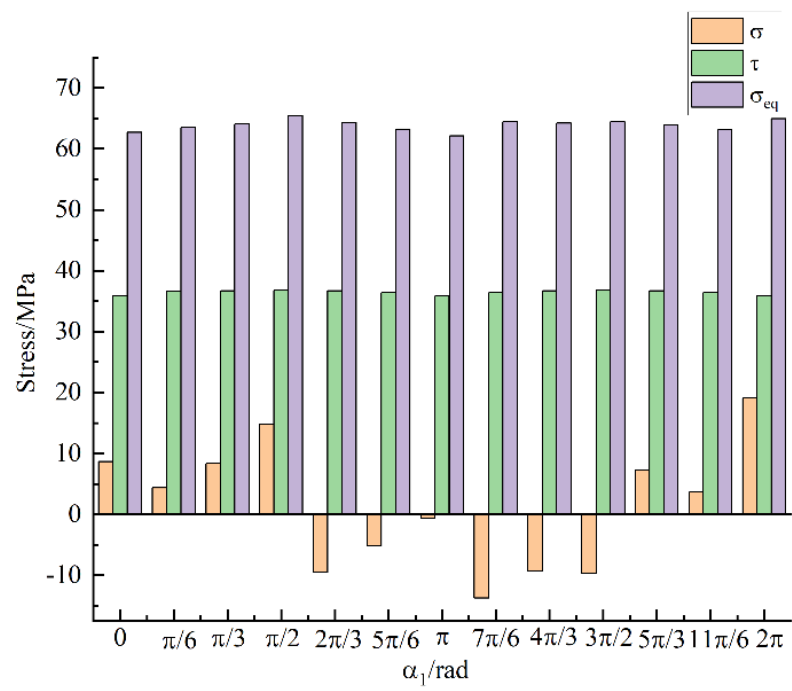
Figure 13. Diagram of stress variation in Section 17.